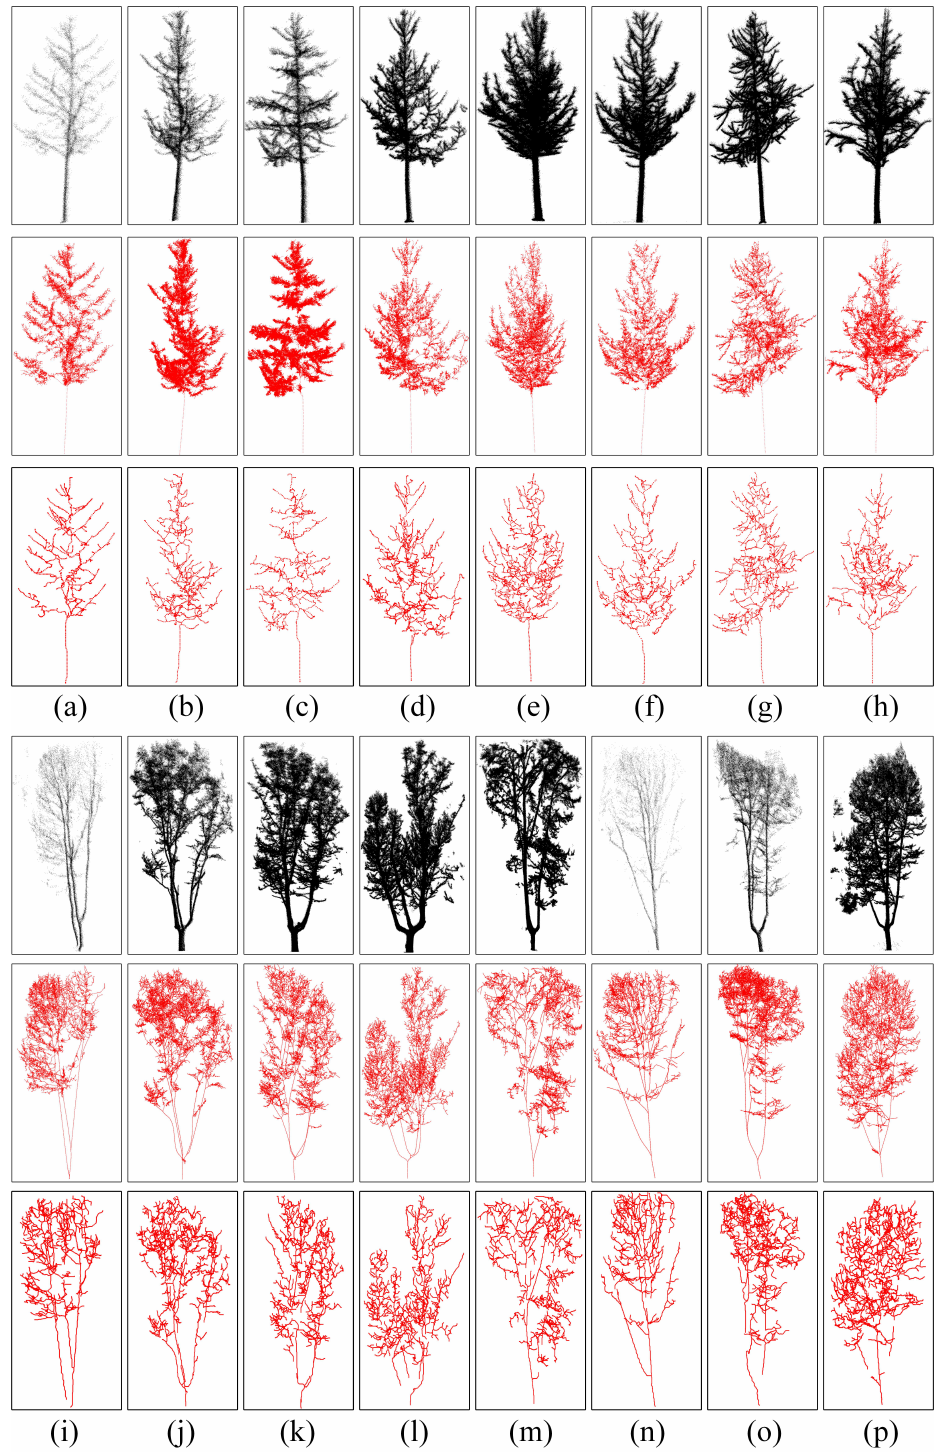
Figure 6. Results of the skeleton extraction. For each subfigure from ( a – p ), the first row shows the input data, the second row shows the result of AD [17], and the last row shows our